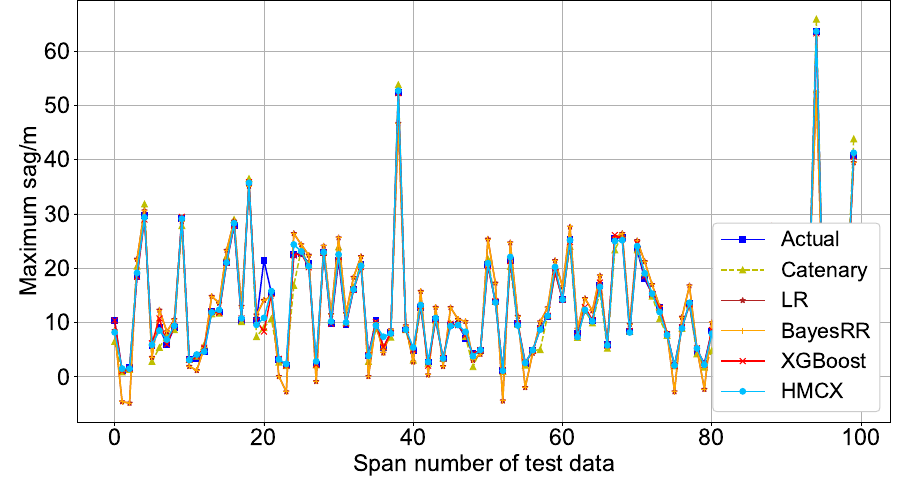
Figure 9. Sag estimation results of all data.